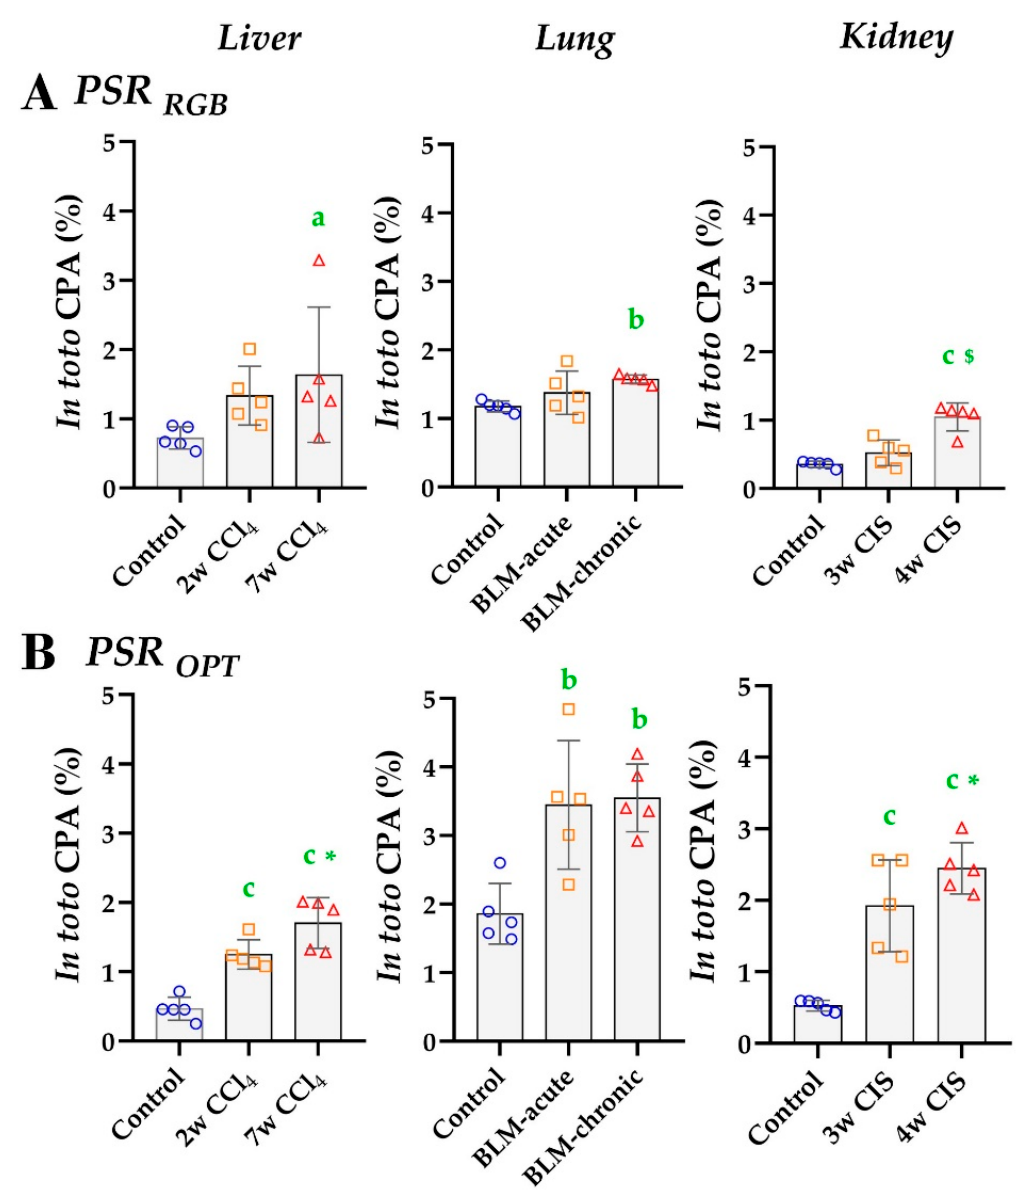
Figure 5. In toto CPA analyses using PSR RGB ( A ) vs. PSR OPT ( B ) filtering method for signal detection. Quantification performed on entire tissue sections (ROEs excluded). One-way ANOVA with Fisher’s post-hoc test. a: p < 0.050, b: p < 0.010, c: p < 0.001 vs. controls; *: p < 0.050, $: p < 0.001 last time point vs. intermediate time